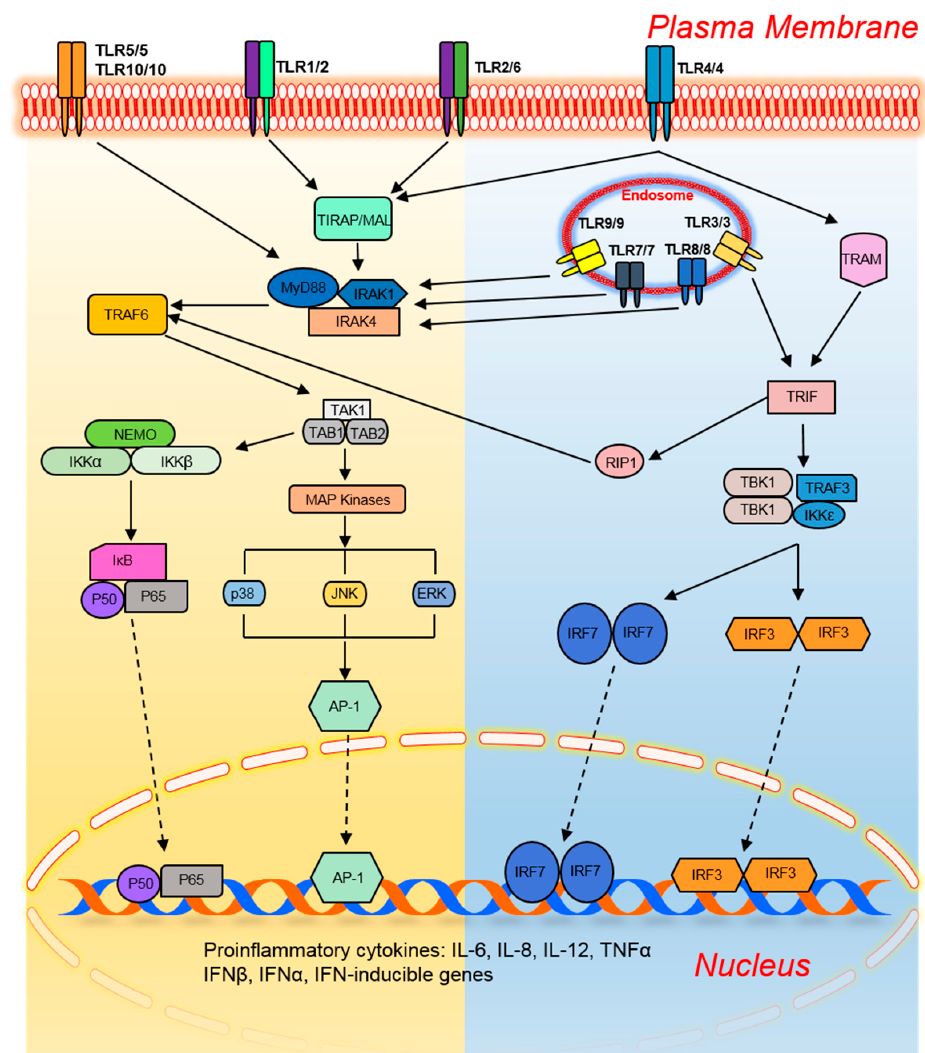
Figure 1. A generalized Toll-like receptor signaling mechanism, adapted from [30]. TLRs are subdivided into two main categories based on their location, cell surface or endosomal; they are activated by their respective PAMPs and damage-associated molecular patterns. After recognizing respective ligand(s) via extracellular domains, TLRs form homo- or heterodimers and interact with cytoplasmic adaptor molecules (myeloid di ff erentiation primary response protein 88 (MyD88), TIRAP (MAL), TRIF, or TRAM) through their cytoplasmic TIR domain. Most of TLRs activate downstream signaling in a MyD88-dependent manner with or without recruiting MAL; however, TLR3 (only) and TLR4 (alternatively) use TRIF / TRAM adaptors to activate IRFs. The activation of a TLR signaling pathway leads to the translocation of transcription factors (NF- κ B (p50 or p65), AP-1, IRF3, and IRF7) into the nucleus and allows them to bind the target sequence(s) of inflammatory and interferon-responsive genes. Abbreviations: TLR, Toll-like receptor; TIR, Toll / interleukin-1 receptor domain; MAL, MyD88 adaptor like; MyD88, myeloid di ff erentiation primary response 88; TRAM, TRIF-related adaptor molecule; TRIF, TIR domain-containing adaptor inducing interferon β ; IRAK, interleukin receptor-associated kinase; RIP, receptor-interacting protein; TRAF, tumor necrosis factor receptor (TNFR)-associated factor; TAB, TAK-1–binding protein; TAK1, transforming growth factor β -activated kinase 1; TBK1, TANK-binding kinase 1; NEMO, NF- κ B essential modulator; I κ B, inhibitor of κ B; IKK, inhibitor of κ B kinase; MAP, mitogen-activated protein; ERK, extracellular signal–regulated kinase; JNK, c-Jun N-terminal kinase; p38, protein 38; AP-1, activated protein 1; IFN, interferon; IL, interleukin; IRF, interferon response factor; NF- κ B, nuclear factor κ B; TNF- α , tumor necrosis factor α